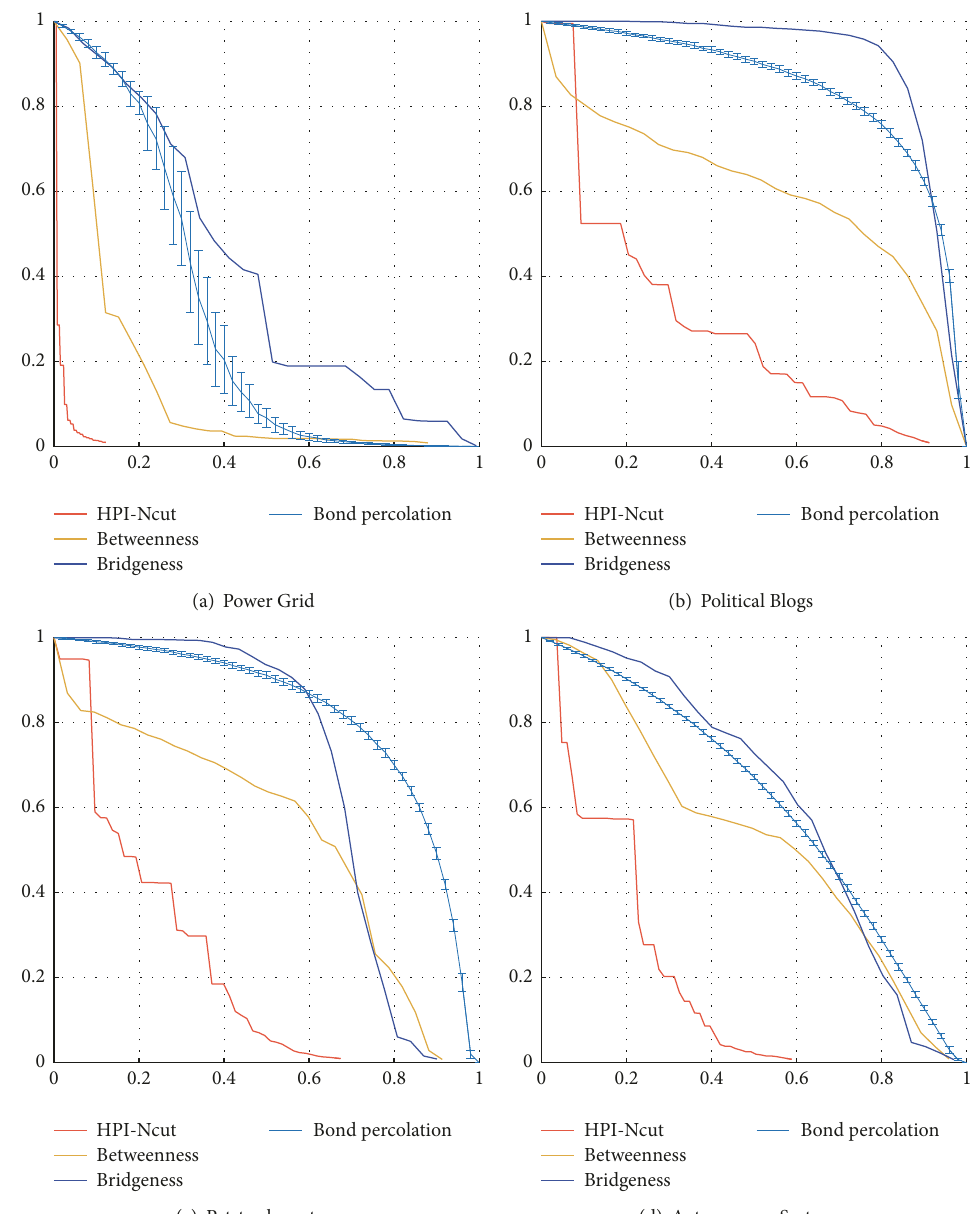
Figure 3: The size of the GCC of the networks versus link removing proportion, comparing with existing link removal-based methods on real networks. The results of the bond percolation are obtained after 100 independent